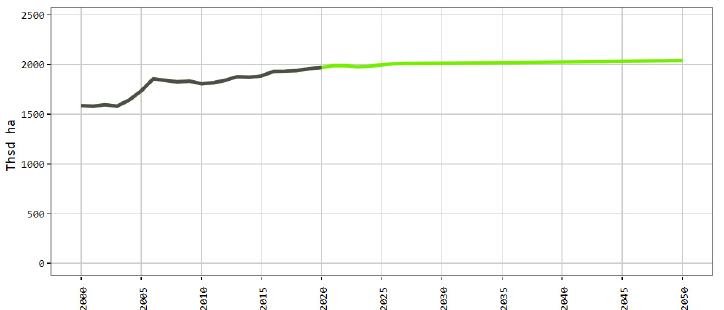
Figure 5. Utilized agricultural area in 2000–2020, with a 2021–2050 projection for Latvia, in thousands of hectares [62].